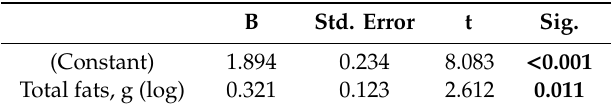
Table 9. Multivariable model predicting HOMA- β , F (1, 91) = 6.823, p = 0.011, adj. R 2 = 0.060. p -values ≤ 0.050 are shown in bold.